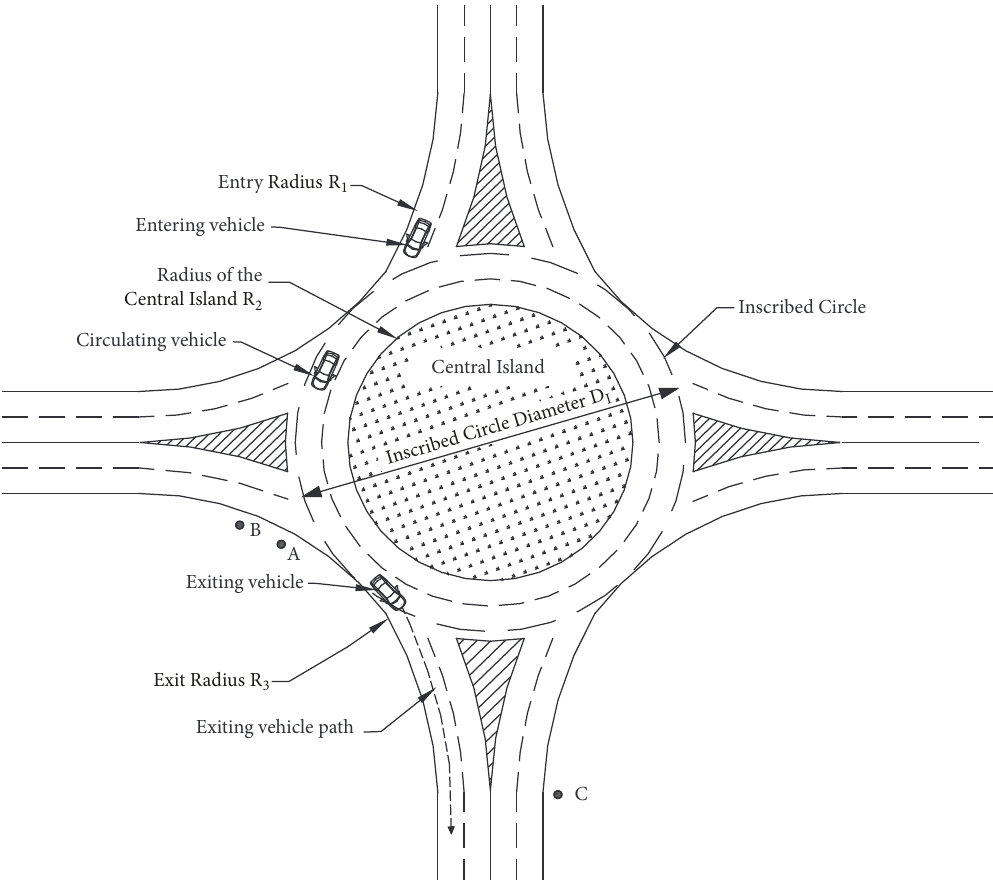
Figure 2: Example of speed measuring locations at a multilane